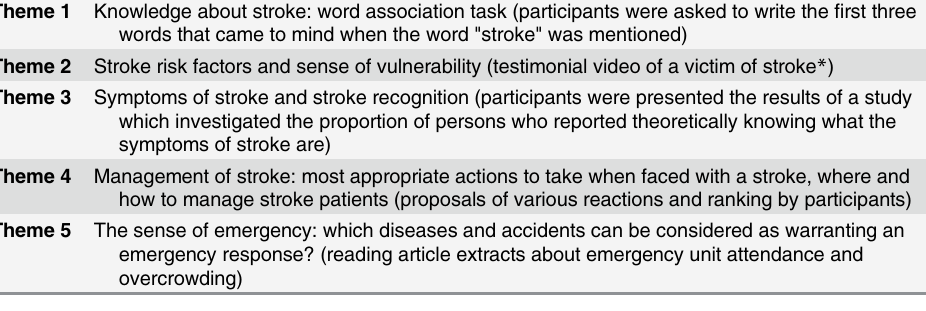
Table 1. Themes developed in focus